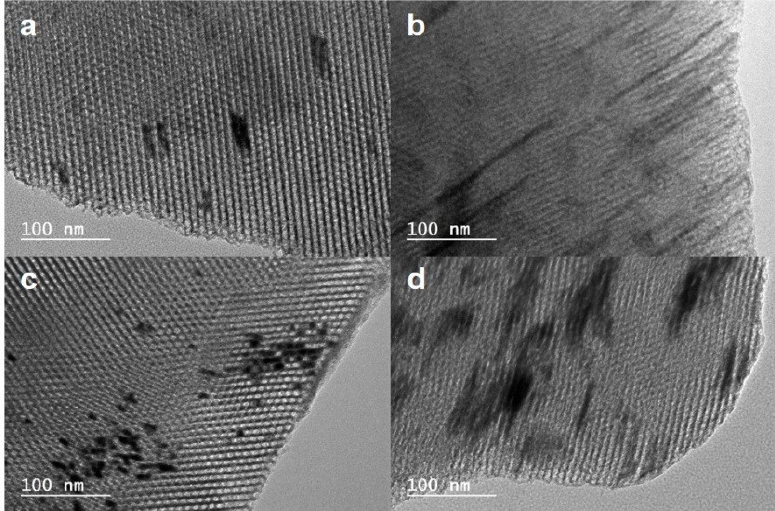
Figure 3. TEM images of MnCe (1:0.5) material before ( a , b ) and after ( c , d ) reaction. The EDX elemental mappings indicate clearly that black particles (in white on the TEM images of Figure 4a,d taken in dark field mode) contain Mn and Ce elements (Figure 4b,c,e,f).